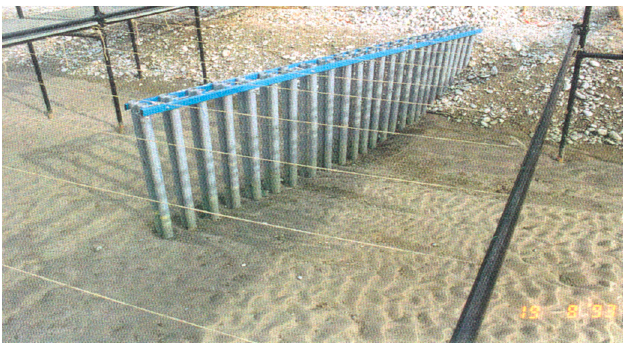
Figure 8. The maximum local scour depth near different types of groynes with various types falling aprons in physical model tests.